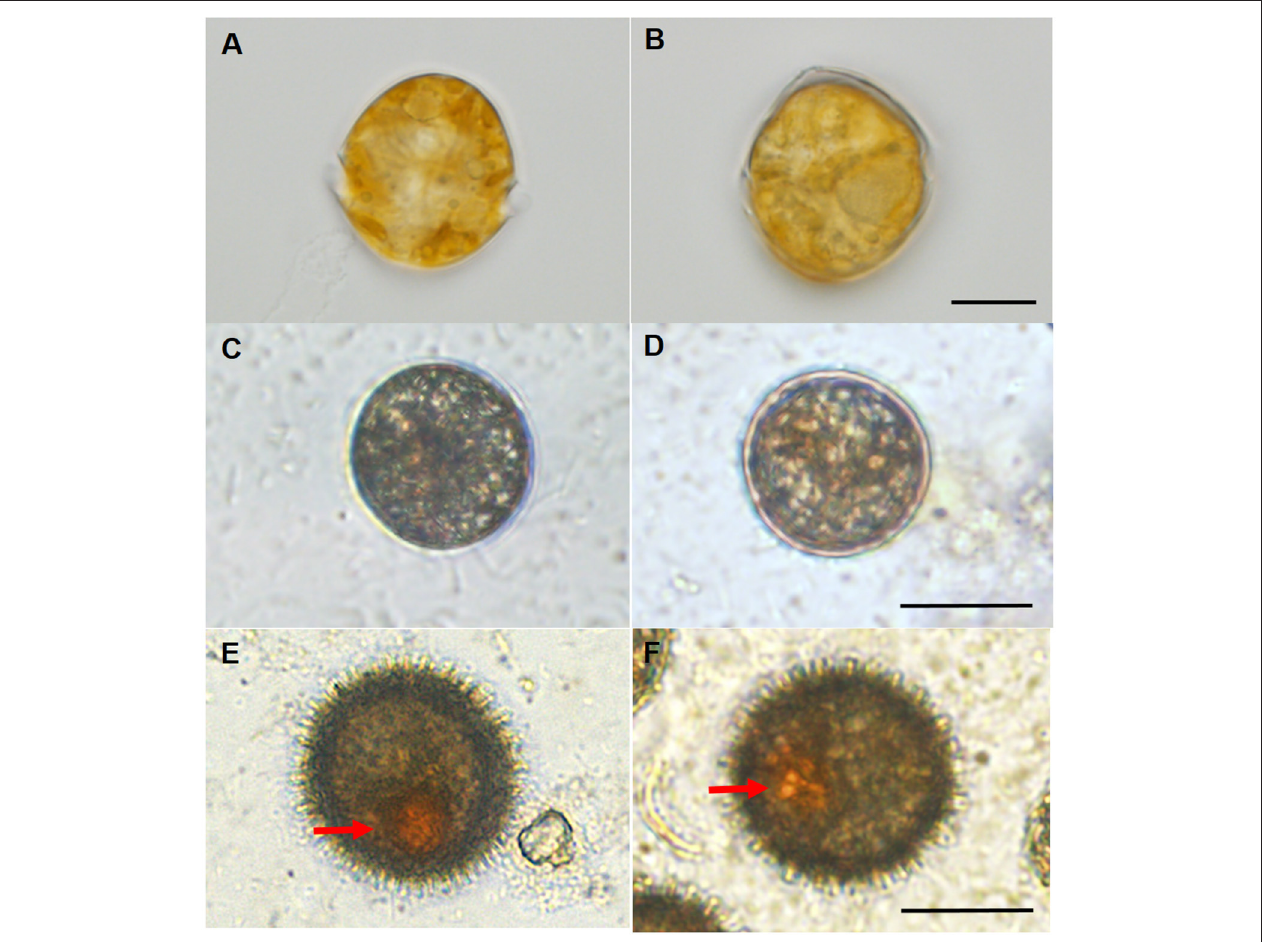
FIGURE 1 | Light microscopic observations for the different morphology of the vegetative cells and resting cysts of Scrippsiella trochoidea . (A,B) A typical swimming (with two flagella) vegetative cell with conical epitheca, round hypotheca, and apical process. The vegetative cells, immature cysts, and mature cysts could be clearly distinguished from morphological features under light microscope, Scale bar = 10 µ m; (C,D) immature cysts (sampled from ∼ 40-day-old culture) with a circular shape, without flagellum (thus not swimming), red body and spine. Scale bar = 20 µ m; (E,F) egg or oval shaped mature resting cysts (sampled from 60-day-old culture) with a red accumulation body (arrows) and numerous surface spines. Scale bar = 20 µ